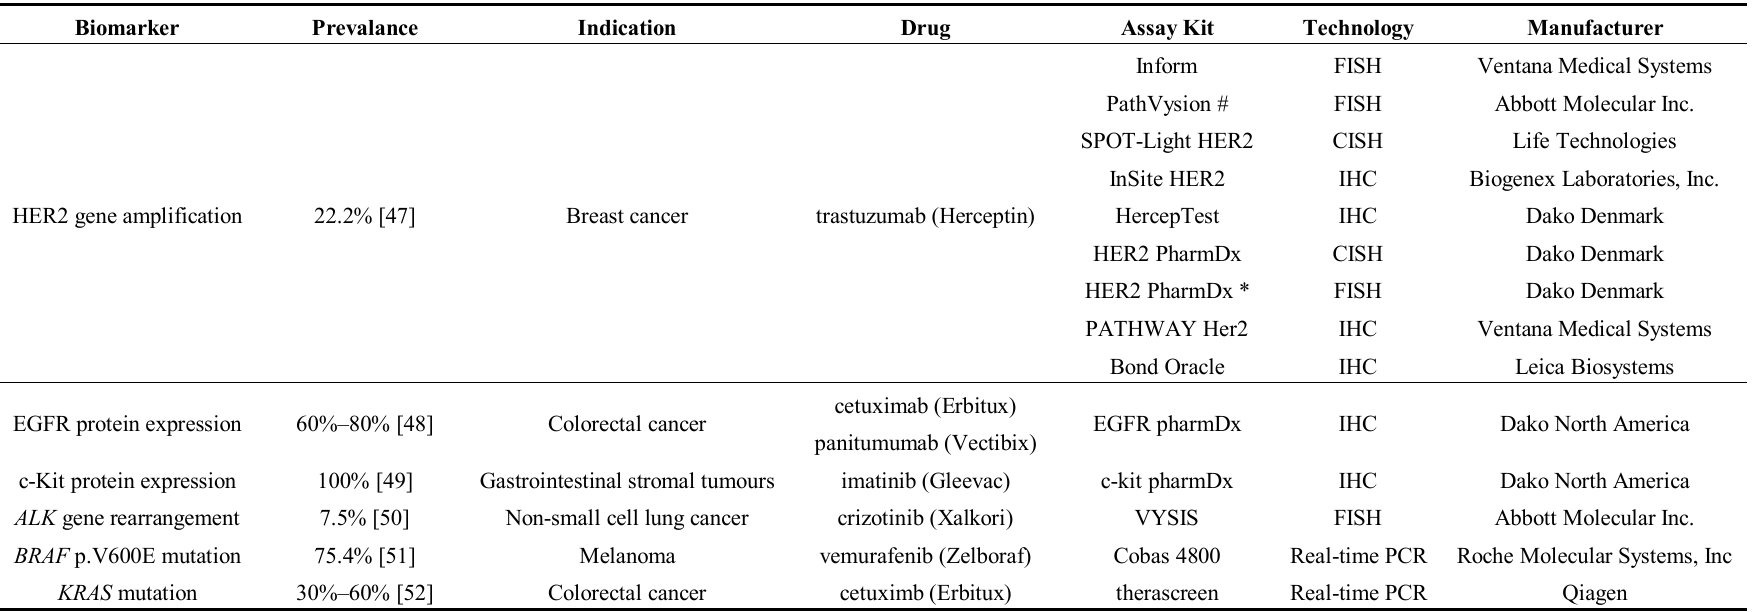
Table 2. In vitro companion diagnostic kits currently licensed by the Food and Drug Administration